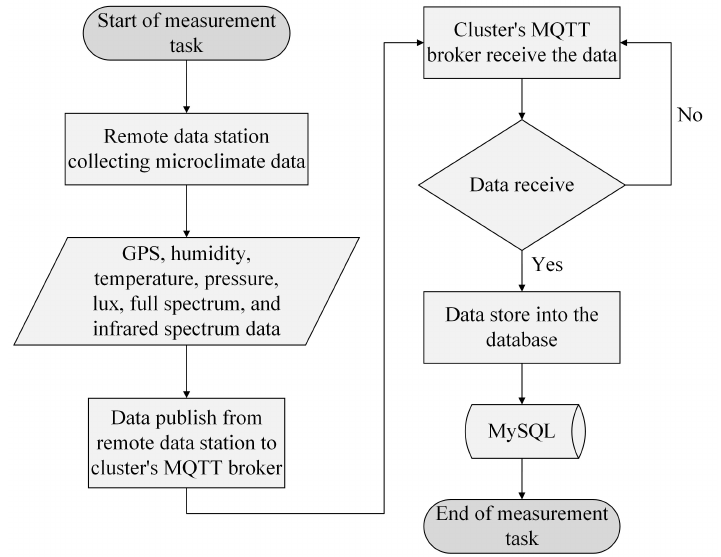
Figure 5. Flowchart showing the sub-process of microclimate data transferring from a remote data station to the database.